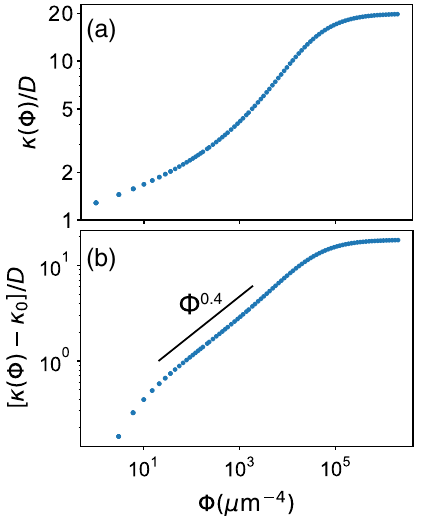
FIG. 12. κ ð Φ Þ obtained using Smoluchowski theory with mean- field approximation. (a) κ ð Φ Þ vs Φ shows that κ ð Φ Þ =D saturates at around 20, which we take to be the value of κ . The value of max κ ð Φ Þ − κ Φ 0 . 4 for small Φ κ 0 =D is between 1 and 2. (b) 0 scales as